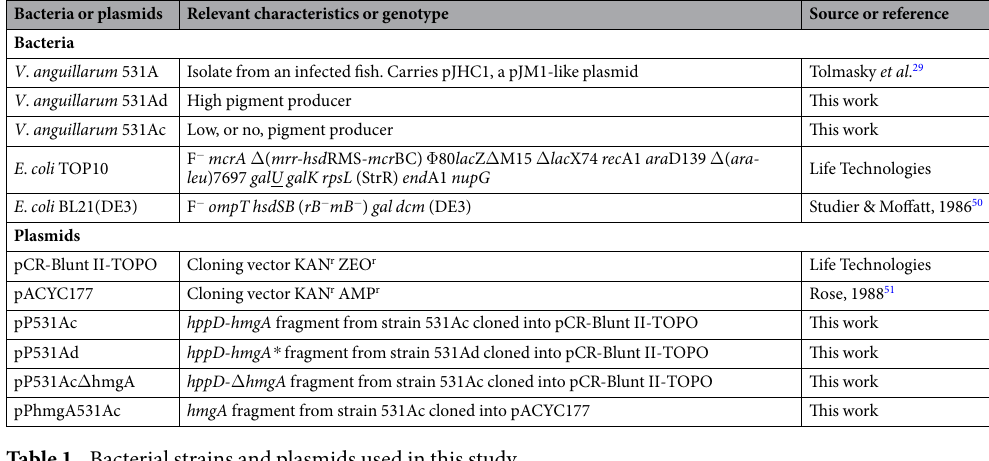
Table 1. Bacterial strains and plasmids used in this study.